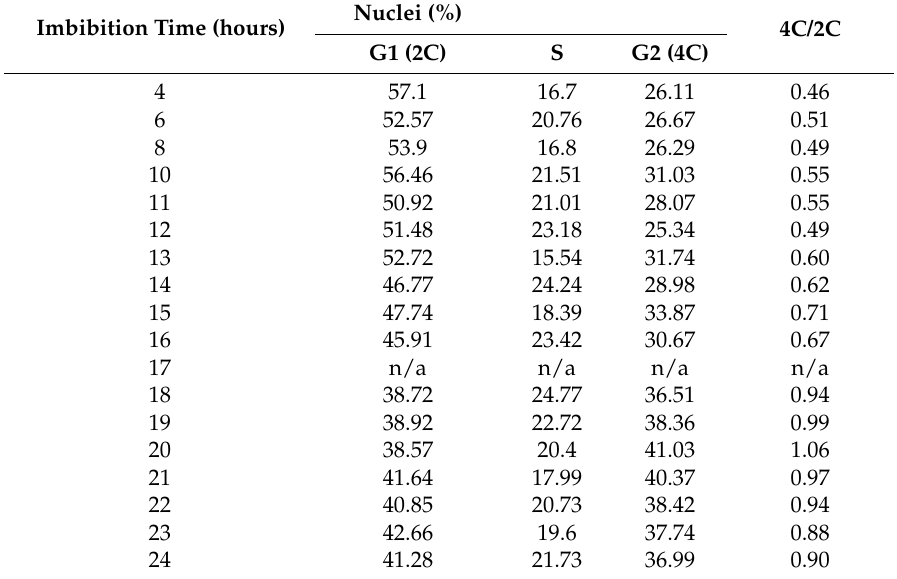
Table 1. Percentage of nuclei in G1, S, and G2 phases in the cells of Brachypodium embryos during imbibition.